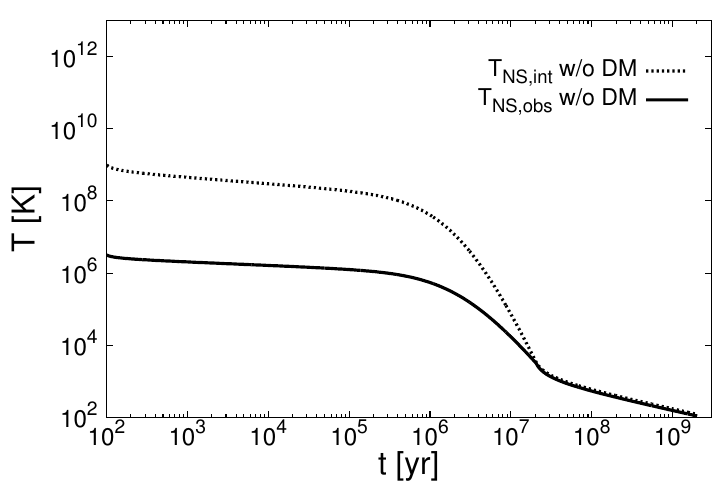
Figure 1 . The time evolution of the interior and observed NS temperatures without DM